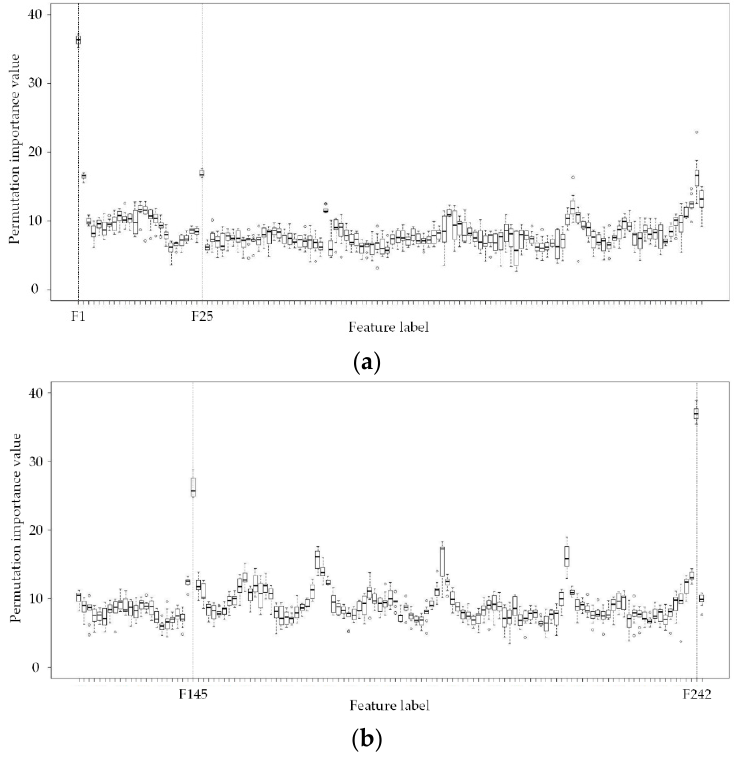
Figure 4. ( a ) Boxplot of the PI value of the first 122 features of day ‐ ahead prediction; ( b ) boxplot of the PI value of the remaining 121 features of day ‐ ahead prediction.